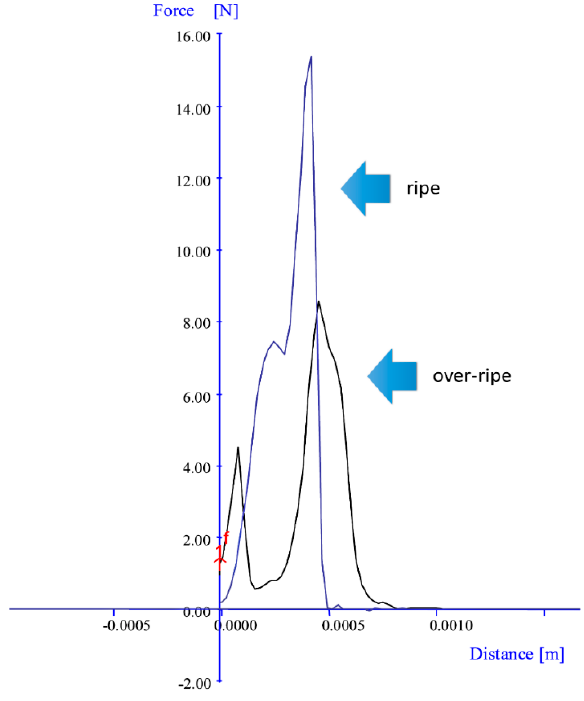
Figure 4. Graph of the relationship between strength and distance resulting from the texture of dried strawberry fruit and its degree of ripeness, namely ripe and over-ripe. Table 4. Hardness (N) of the selected strawberry classes obtained with TA–XT2i texture analyzer. No. Ripe Class (N)